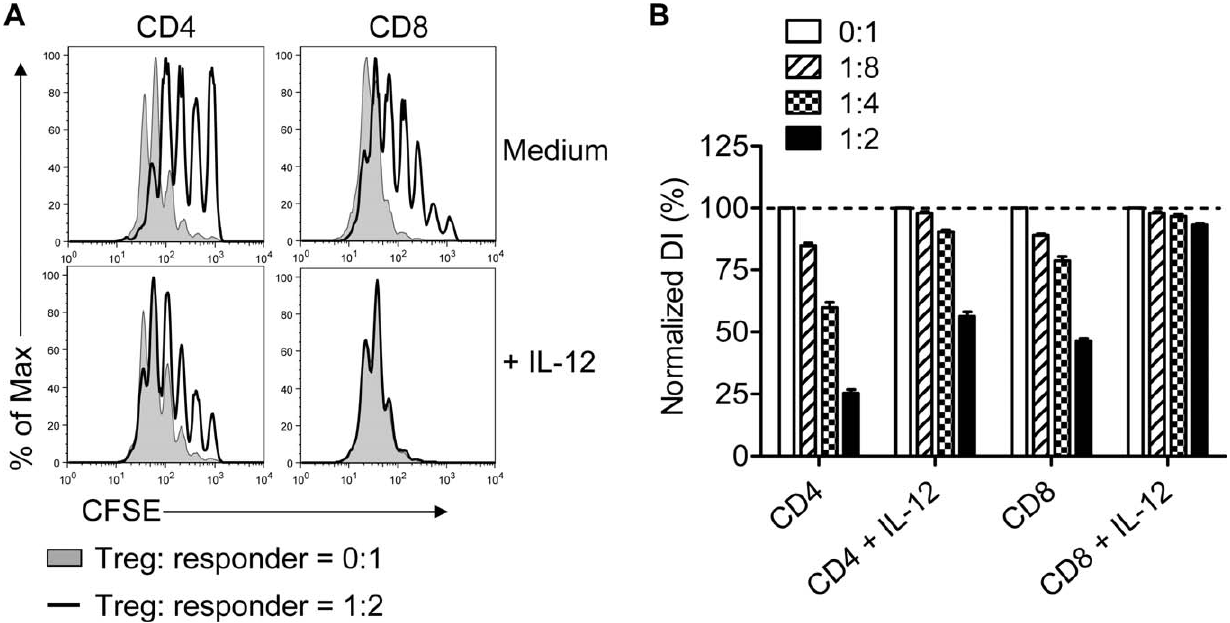
Figure 5. Treg-mediated suppression is reduced in the presence of IL-12. Tregs were isolated from naı¨ve B6 mice and mixed with CFSE- labeled T cells at the indicated ratios. Cells were cultured for 66 hr in the presence of irradiated splenocytes and anti-CD3 mAb with or without IL-12. Samples were analyzed in triplicate. (A) Representative histograms are shown after gating on CD4 or CD8 T cells. (B) DI were calculated and normalized to samples incubated in the absence of Tregs in each group. Data are from one experiment representative of 3 independent experiments.